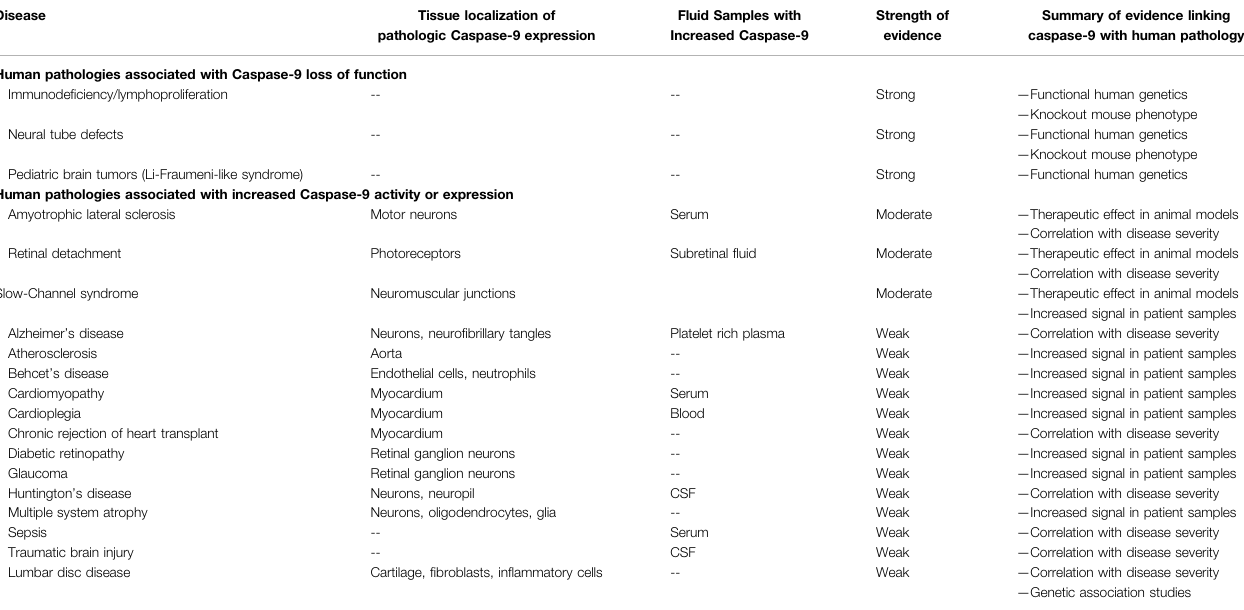
TABLE 7 | Summary of caspase-9 involvement in human degenerative pathologies.